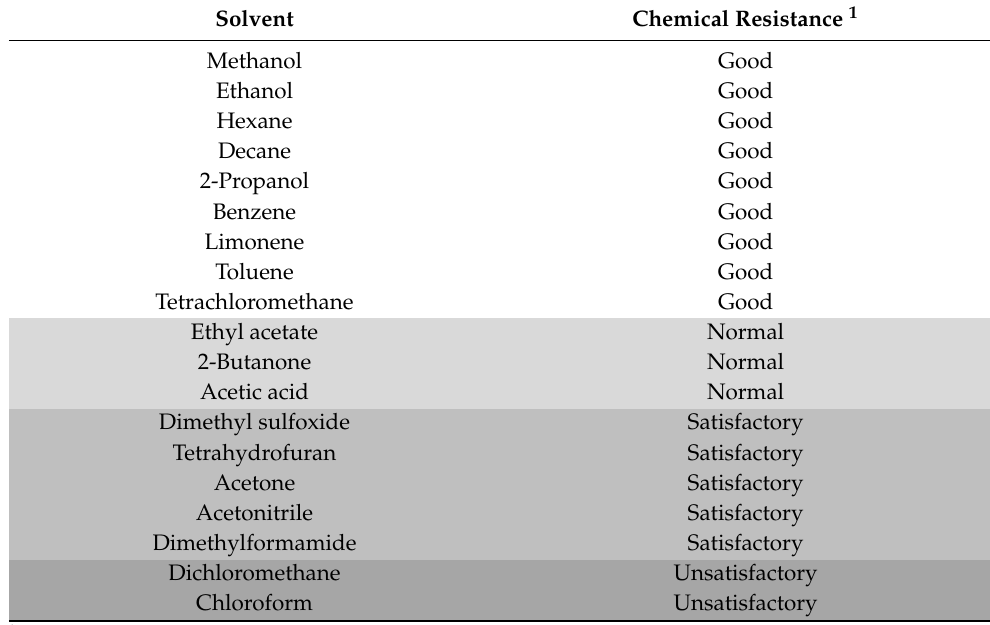
Table 1. The chemical resistance of OSTE-MS in organic solvents at room temperature.